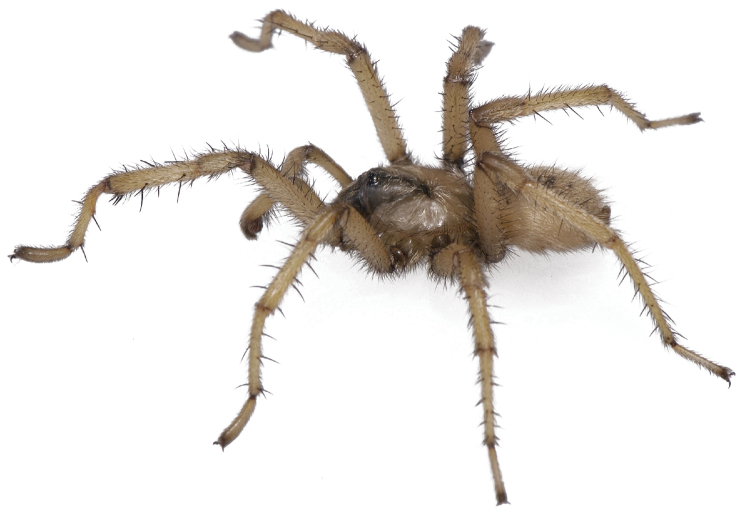
Live photograph, Aptostichus sinnombre sp. n. male holotype (MY3761); note leg I, right hand side missing.